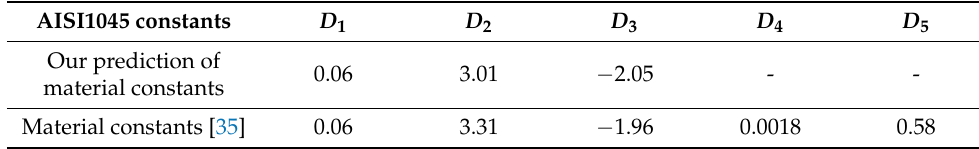
Table 7. Numerical failure parameters of